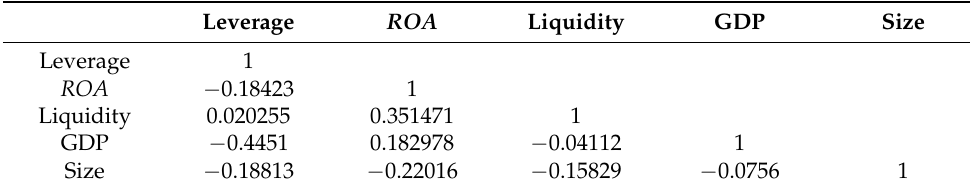
Table 3. Pearson correlation matrix.